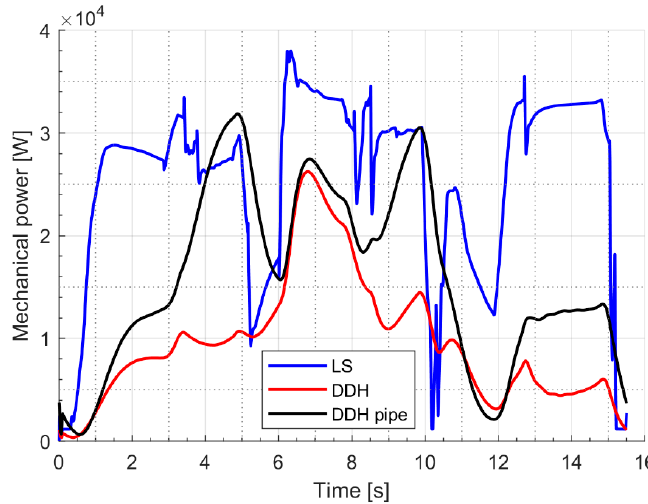
Figure 9. Mechanical power course during digging duty cycle.